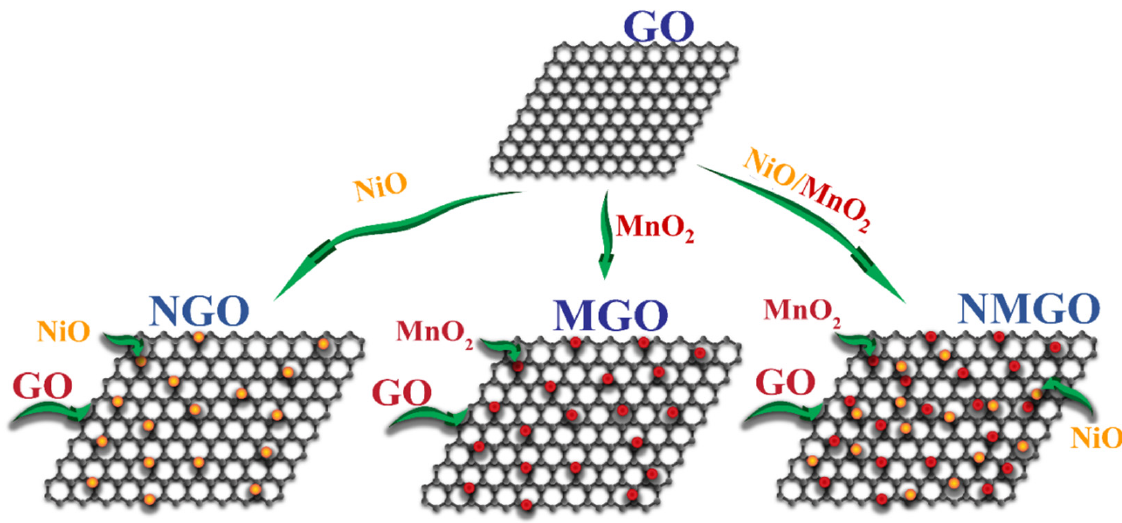
Figure 1 . Schematic illustration for the formation of composites . Figure 1. Schematic illustration for the formation of composites.